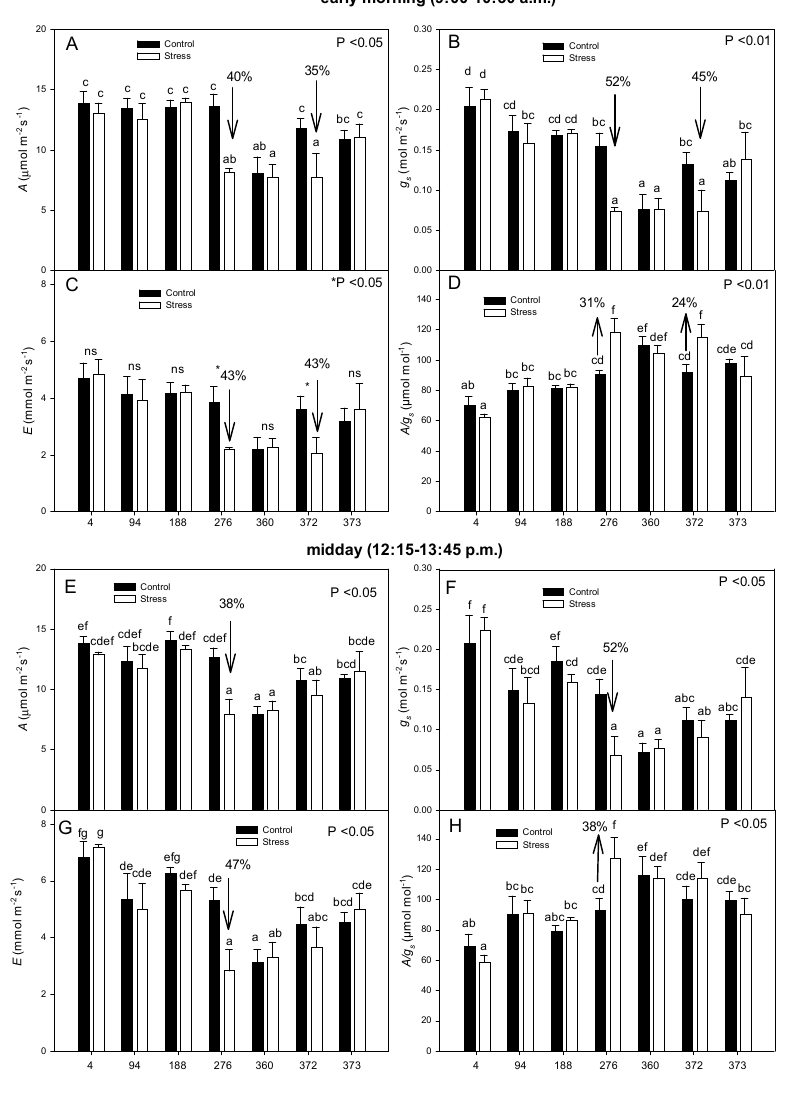
Figure 4. Significant interactive effects of the clone and irrigation treatment on leaf gas exchange parameters measured at early morning and midday during the post-veraison in 2020. Different letters indicate significant differences according to Duncan´s multiple range test at the 95% confidence level. The significant relationships found between midday stem water potential ( Ψ s ) and leaf gas exchange parameters (Figure 5) revealed that: (1) in general, low-vigor clones had lower Ψ s than high-vigor clones (minimum around − 1.7 MPa vs. 1–3 MPa, respectively);